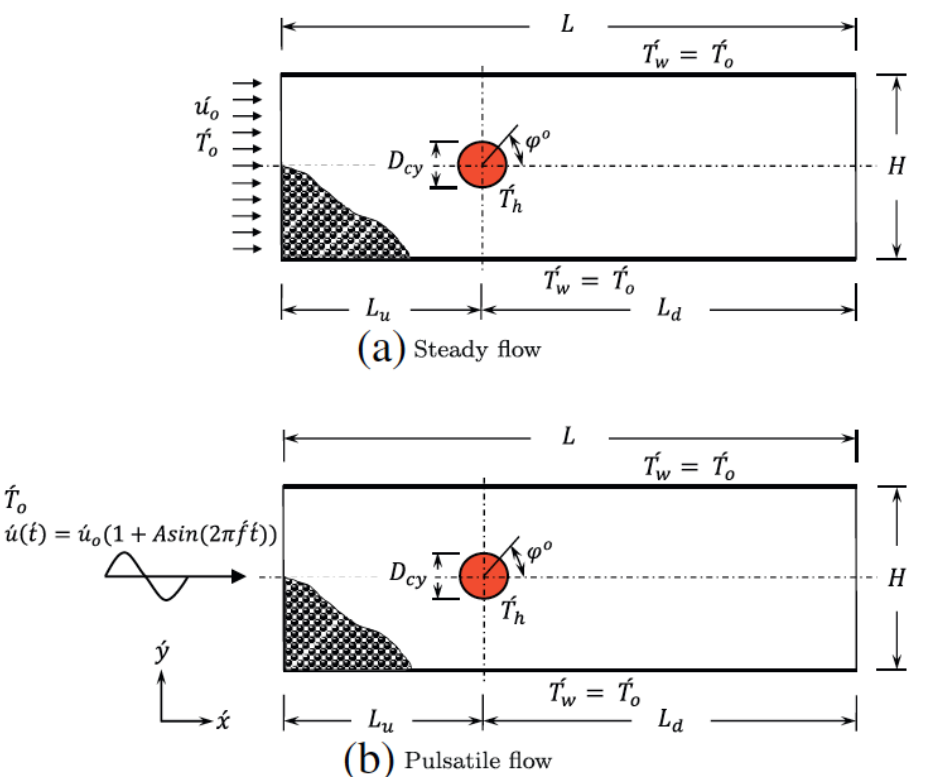
Figure 23. The physical problem considered by Al-Sumaily et al. [49] for convective flow over a hot cylinder embedded in a packed bed, under whether ( a ) steady or ( b ) pulsatile, inlet flow condition.